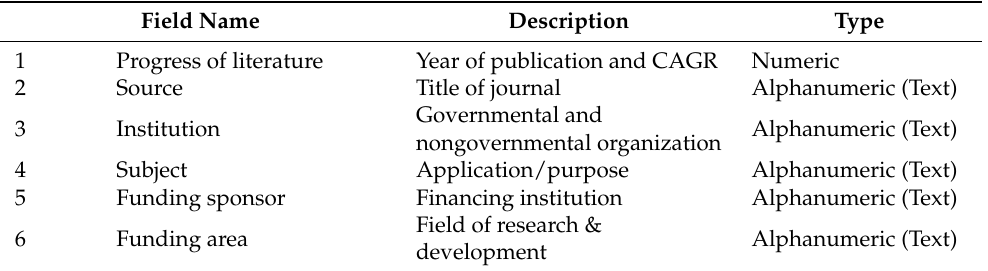
Table 1. Snowballing metrics for extracting relevant bibliometric information to integrative review.